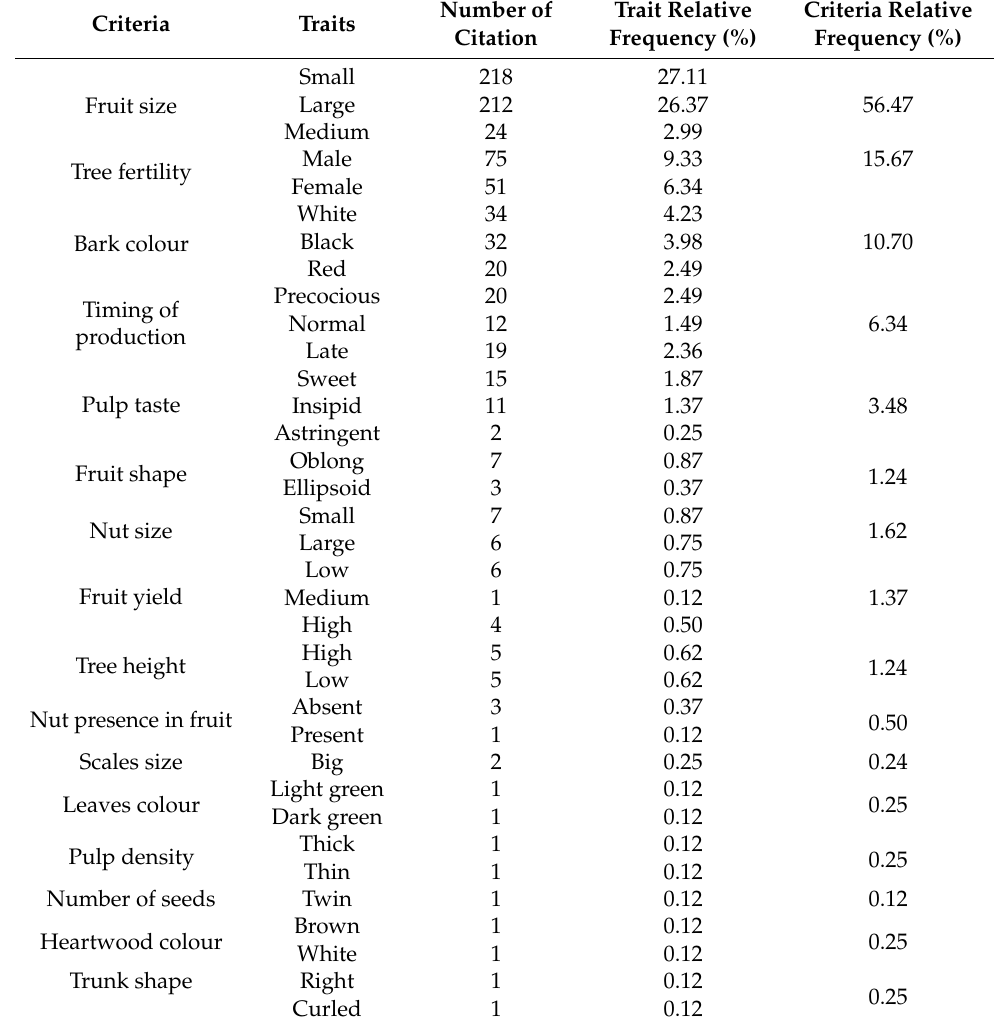
Table 1. Identification criteria of shea morphotypes used by farmers and associated